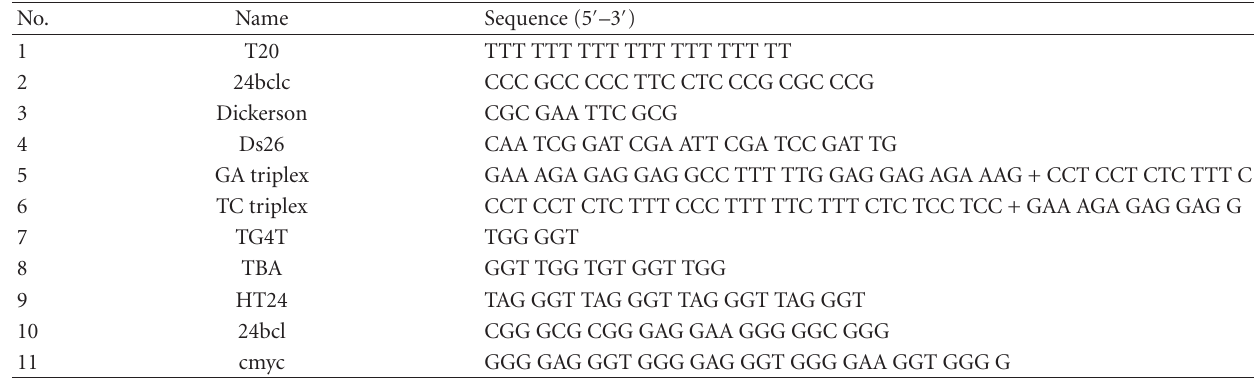
Table 1: Sequences of